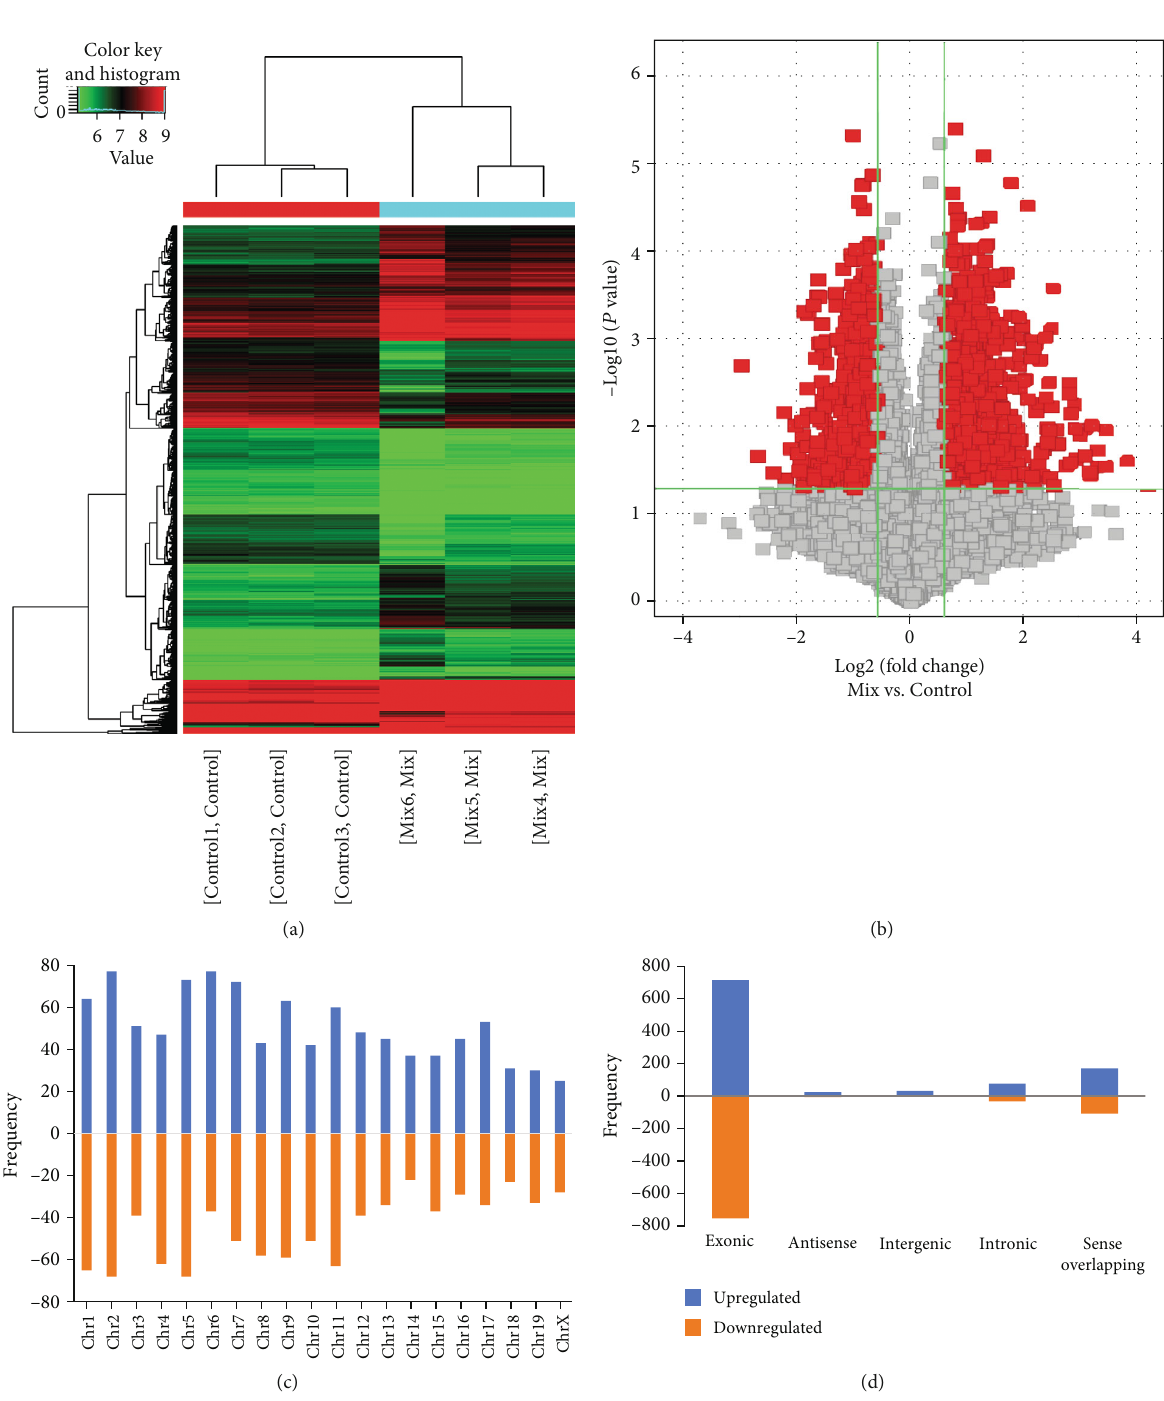
Figure 1: Changed expression pro fi les of circRNAs in cytokines-mediated pancreatic- β cell destruction. (a) The heat map of di ff erentially expressed circRNAs in cytokines-treated pancreatic- β cells and control cells from microarray data. (b) Scatter plots showing di ff erentially expressed circRNAs in cytokines-treated pancreatic- β cells and control cells. (c) Chromosomal frequency distribution of di ff erentially expressed circRNAs. (d) Types of di ff erentially expressed circRNAs. The circRNAs were classi fi ed into fi ve types including exonic, antisense, intergenic, intronic, and sense overlapping. Blue and orange indicate upregulated and downregulated circRNAs,